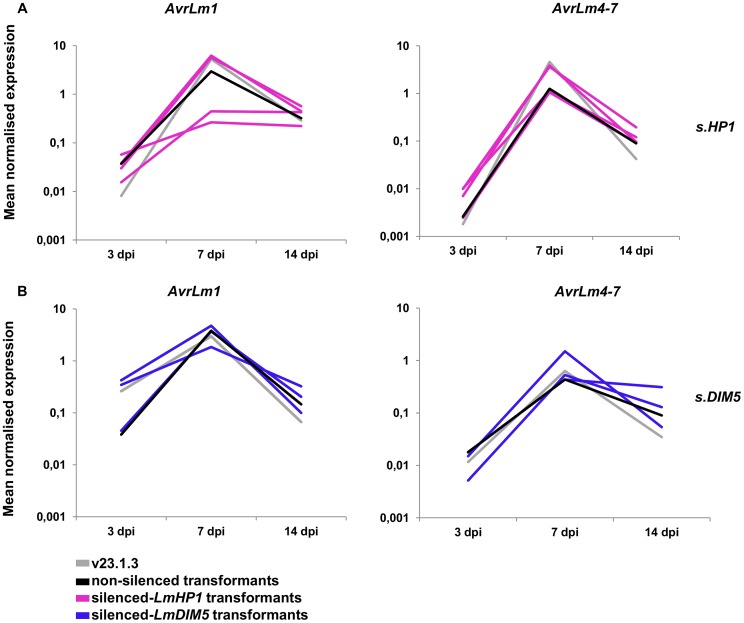
Expression of two effector genes in the silenced-LmHP1 and -LmDIM5 transformants during infection.Expression of AvrLm1 and AvrLm4-7 was measured by qRT-PCR from 3 to 14 days post infection (dpi) of oilseed rape cotyledons (susceptible cultivar Westar) in a wild type strain (grey lines), a transformant that has not been silenced either for LmHP1 or LmDIM5 (black lines) and (A) four silenced-LmHP1 transformants or (B) four silenced-LmDIM5 transformants by qRT-PCR. Gene expression levels are relative to β-Lmtubulin. Expression of Lmactin relative to β-Lmtubulin was used as a control.